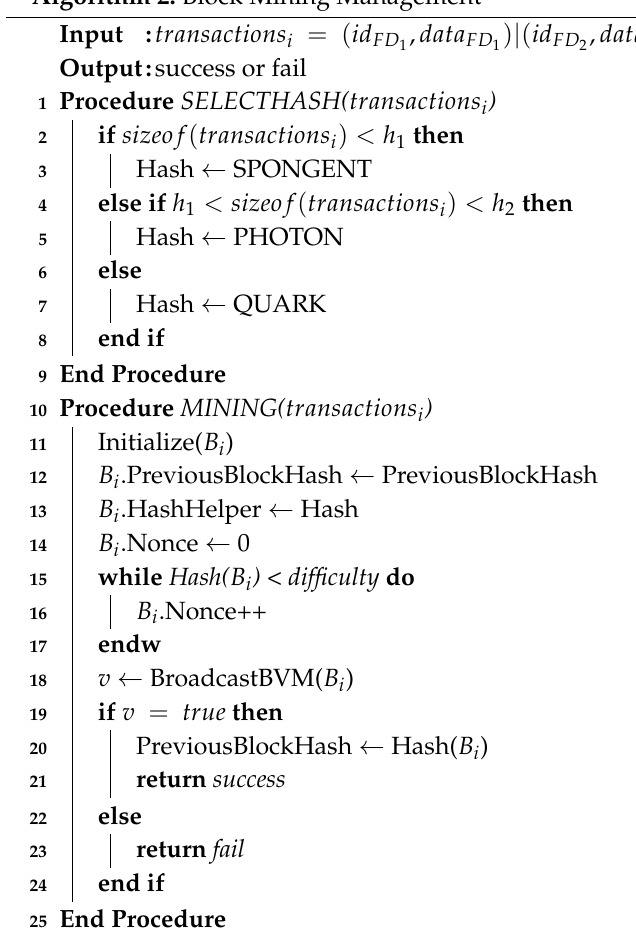
Algorithm 2: Block Mining Management